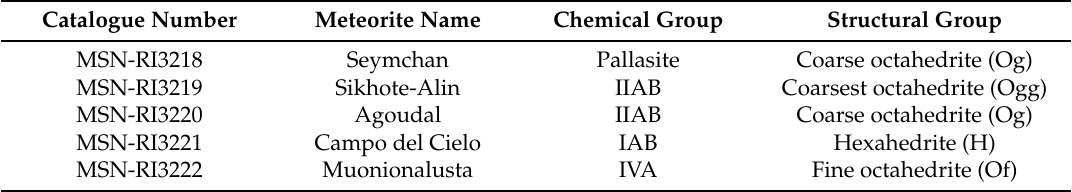
Table 3. Summary of the chemical and structural characteristics of the analyzed